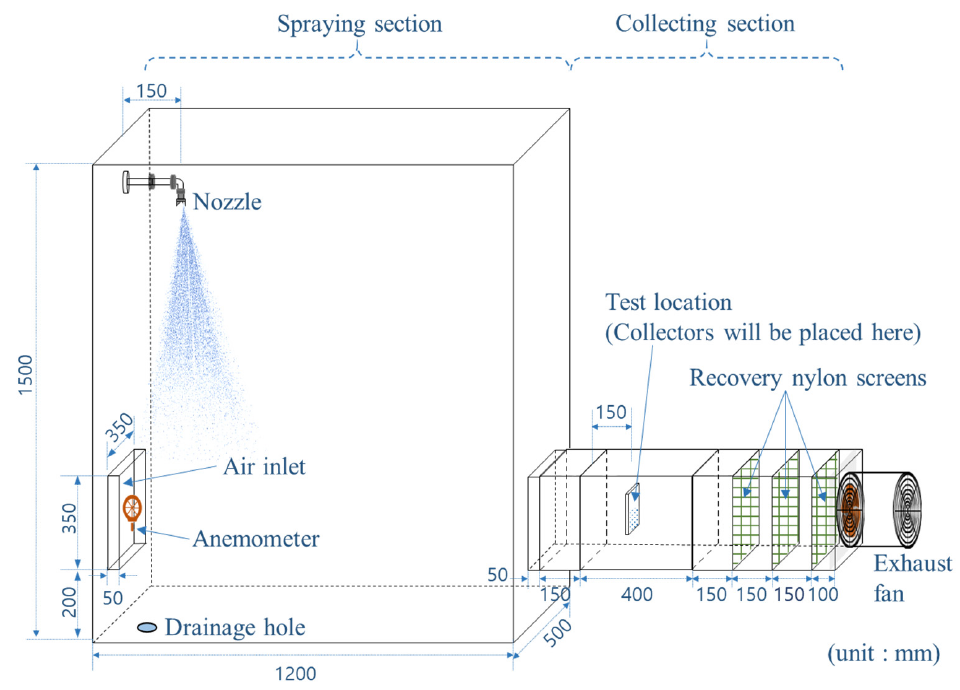
Figure 1. Experimental setup of the small spray-drift wind